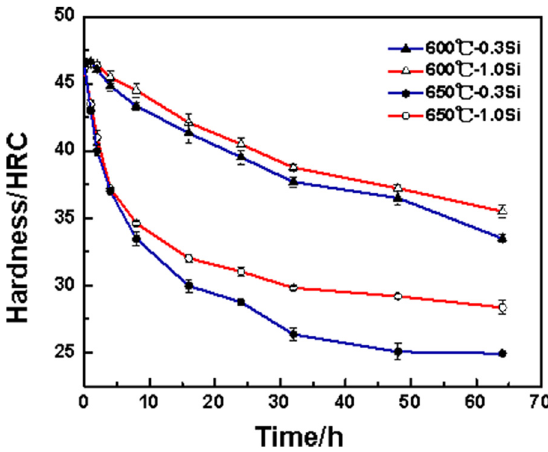
Figure 2. Thermal stability curve of tested steels.